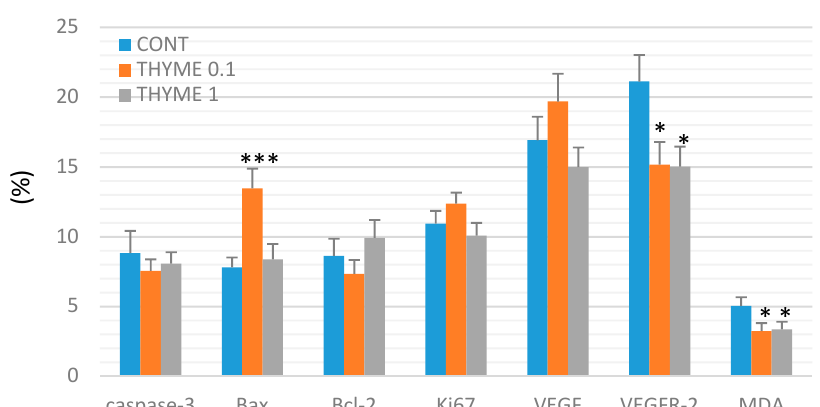
Figure 3. Immunohistochemical evaluation of caspase-3 (cytoplasmic), Bax, Bcl-2, Ki67, VEGFA, VEGFR-2, and MDA expression in rat mammary carcinoma cells after the administration of T. vulgaris in two doses. Data are expressed as mean ± SEM. Significant difference, * p < 0.05, *** p < 0.001 versus CONT. The figure represents the expression of proteins quantified as the average percentage of antigen positive area in standard fields (0.5655 mm 2 ) of tumor hotspot areas. The values of protein expression were compared between treated (THYME 0.1, THYME 1) and non-treated (control) carcinoma cells of female rats; at least 60 images for one marker were analyzed.